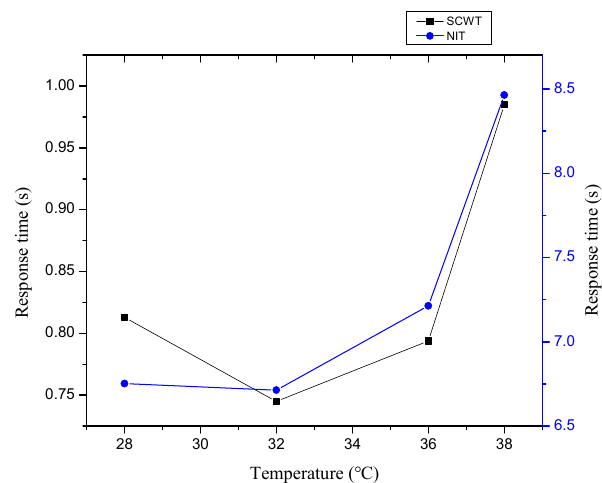
Figure 6. The relationships between the response time and the temperature.